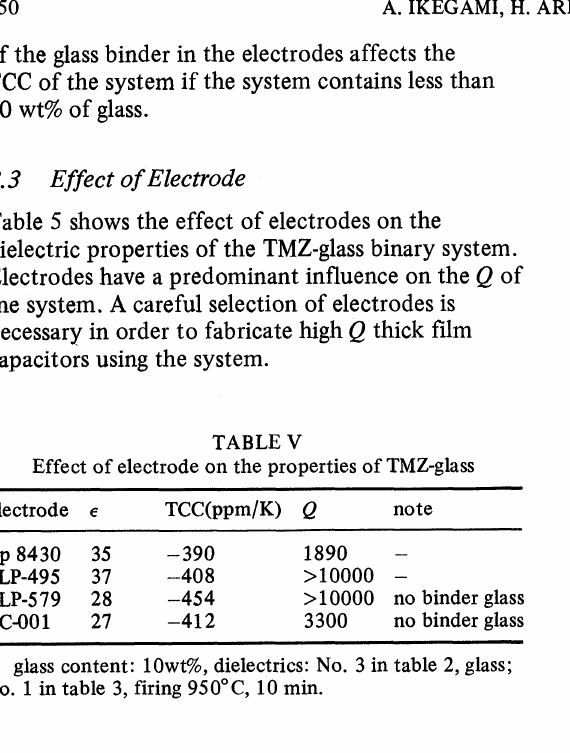
Dielectrics:No6 in tab.l, glass:No4 Electrode: Ag/Pd, binder